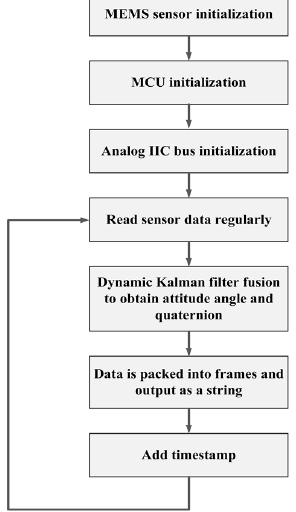
Figure 4. Data processing program flowchart.